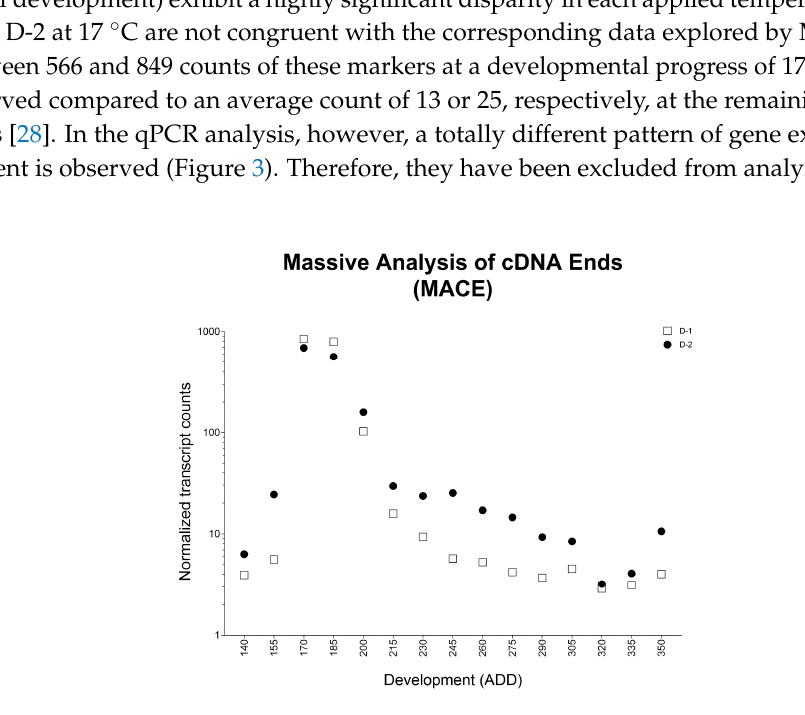
Figure 2. Normalized transcript counts of contigs identified for the markers D-1 and D-2 in the previous massive analysis of complementary DNA ends (MACE) study (17 °C) [28] plotted against pupal age (ADD).